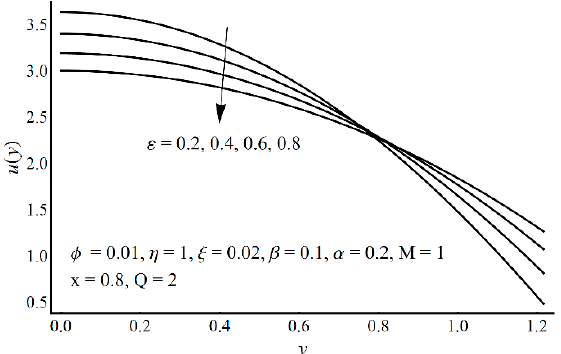
Figure 4. Axial velocity for various values of cilia length parameter ε .